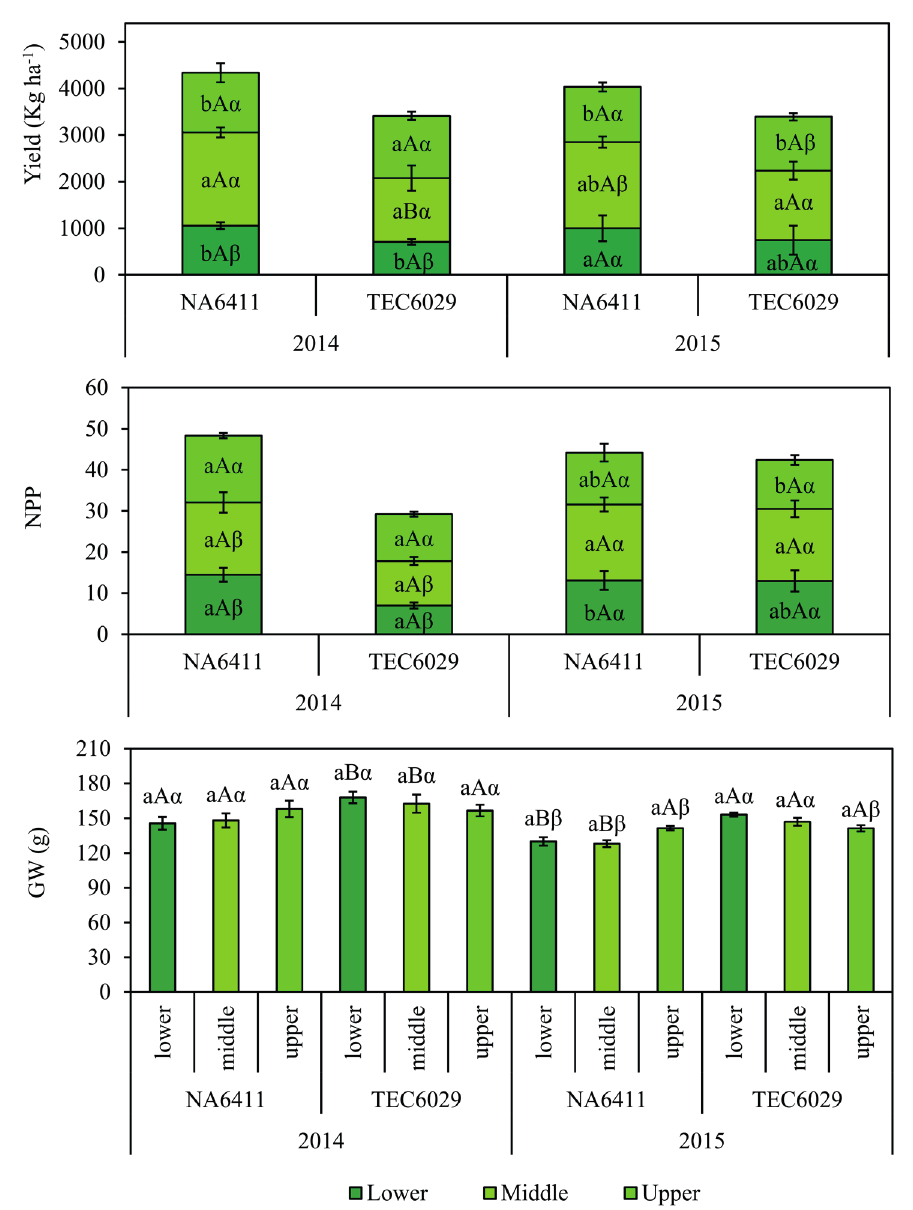
Figure 7 - Yield, number of pods per plant (NPP) and 1000-grain weight (GW) in different canopy strata of the soybean cultivars NA6411 and TeC6029 in two crop years (2013/2014 and 2014/2015) in a field experiment in Frederico Westphalen, Brazil. Bars represent the standard deviation of mean values ± Se. * Means followed by the same letter, lowercase comparing the crop years, uppercase soybean cultivars and greek letters comparing the canopy strata did not differ significantly (Tukey test at 0.05 probability of